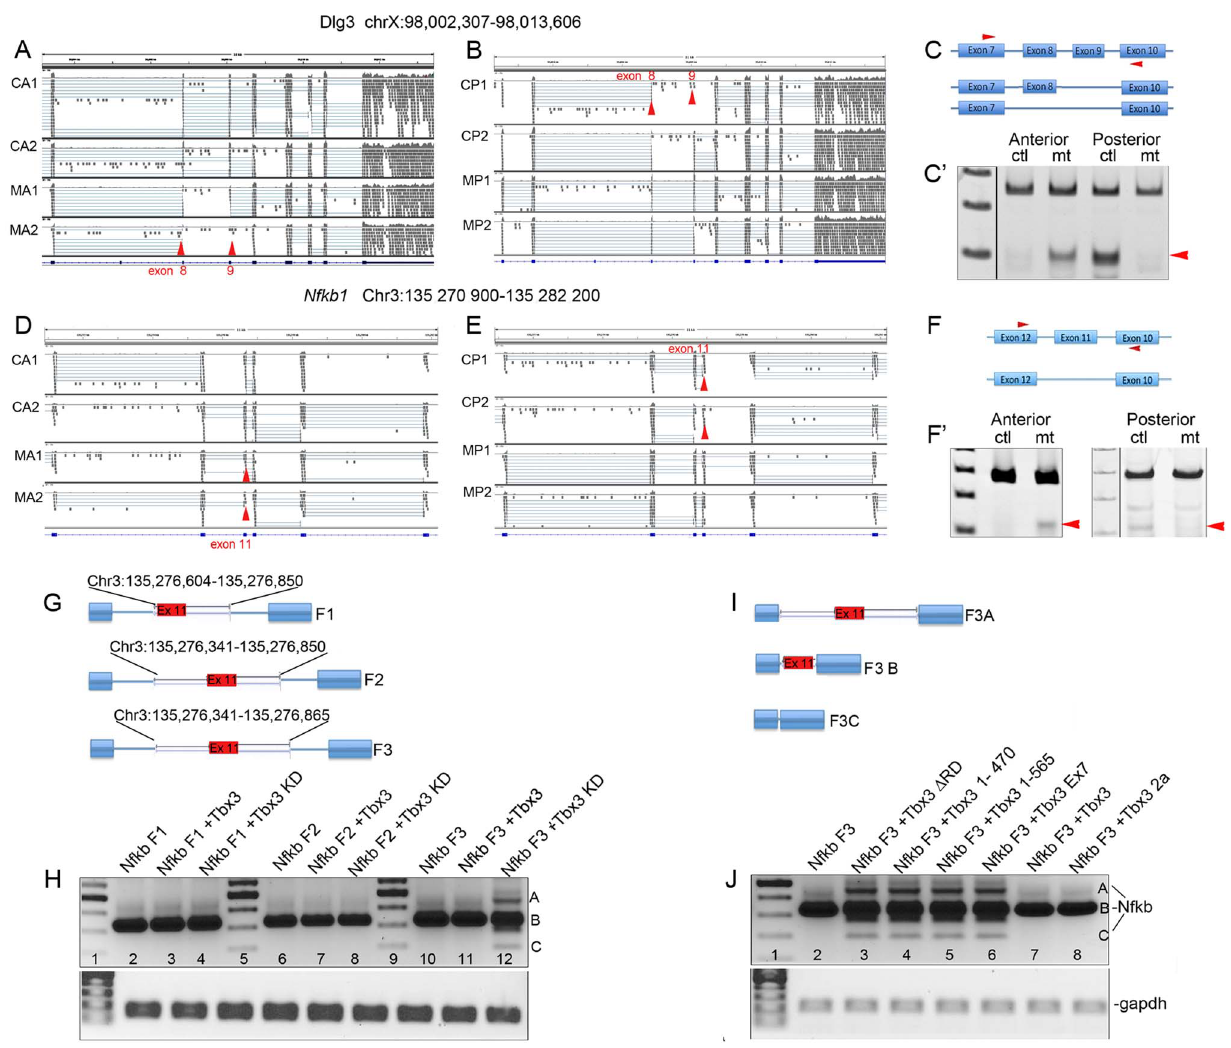
Figure 4. Tbx3 regulates alternative splicing invivo . A, B, D, E) Screen shots from the Integrated Genome Viewer (IGV) comparing RNA-Seq reads obtained from wild type/control anterior (CA1, CA2) or posterior (or CP1, CP2) limb bud mRNA libraries with those from Tbx3;Prx1Cre mutants after conditional ablation of Tbx3 in anterior or posterior limb bud mesenchyme (MA1, MA2 or MP1, MP2, respectively). Red arrowheads indicate positions of exons that are differentially spliced in a Tbx3-dependent manner. A) Loss of Tbx3 causes exclusion of Dlg3 exons 8 and 9 in the mutant anterior compartment (MA1, MA2 red arrowheads). B) Loss of Tbx3 causes inclusion of Dlg3 exons 8 and 9 in the mutant posterior compartment (MP1, MP2 red arrowheads). C) Schematic of splice variants and location of PCR primers used to detect different Dlg3 isoforms by RT-PCR assay of control versus Tbx3 mutant mRNAs (C 9 , Anterior and Posterior compartments, ctl, control; mt, mutant). D) Loss of Tbx3 causes exclusion of Nfkb1 exon 11 in the mutant anterior compartment (MA1, MA2 red arrowheads). E) Loss of Tbx3 causes inclusion of Nfkb1 exon 11 in the mutant posterior compartment (MP1, MP2 red arrowheads). F) Schematic of splice variants and location of PCR primers used to detect different Nfkb1 isoforms by RT- PCR assay of control versus Tbx3 mutant mRNAs (F 9 , Anterior and Posterior compartments, ctl, control; mt, mutant). G) Schematic of Nfkb1 exon 11 minigenes in which exon 2 of pRHCglo was replaced by different Nfkb1 genomic fragments (F1, F2, F3). H) Splicing products assayed by RT-PCR from the Nfkb1 minigenes containing fragments F1, F2 or F3 in the presence of Tbx3 or after knockdown (KD). Only F3 confers differential splicing (lane 12). I) Schematic of splice variants obtained in vivo (sequence confirmed) in response to TBX3 knockdown. J) Splicing products assayed by RT-PCR from the Nfkb1 F3 minigene in the presence of Tbx3 different Tbx3 mutant proteins. C-terminal mutants (lanes 3–6) result in alternate splicing similar